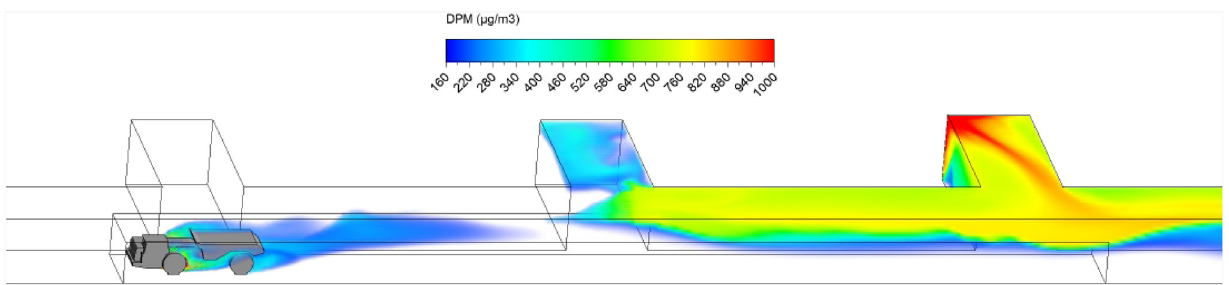
Fig. 13 DPM distributions in scenario 1 during the hauling operation at 240 s